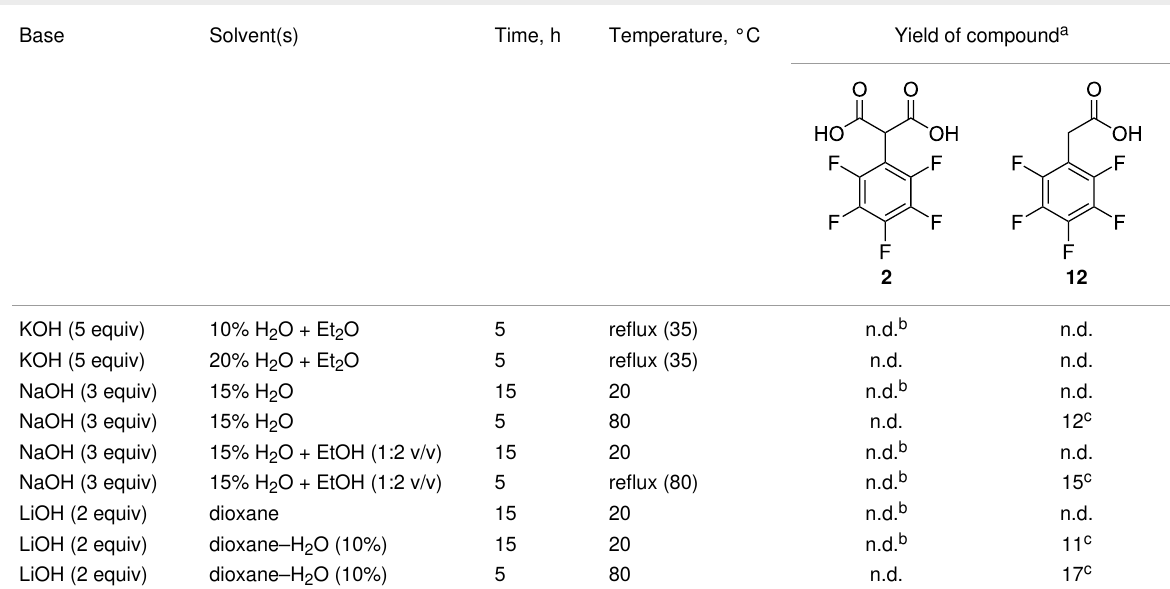
Table 1: Hydrolysis of 3 under basic